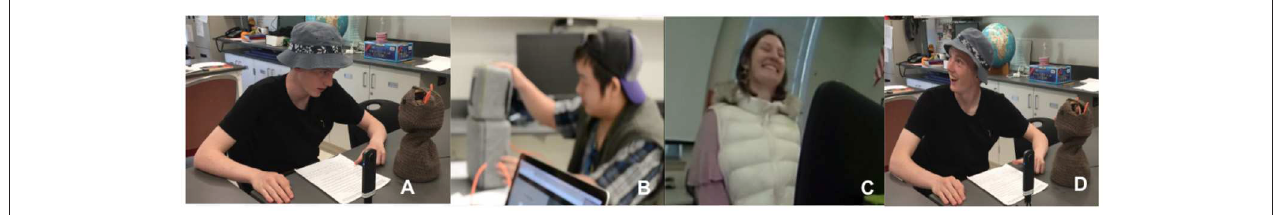
FIGURE 8 | Examples of the emotional responses teens had during robot interaction. Eye contact (A) , physical contact (B) , laughing (C) , social referenceing (D) .